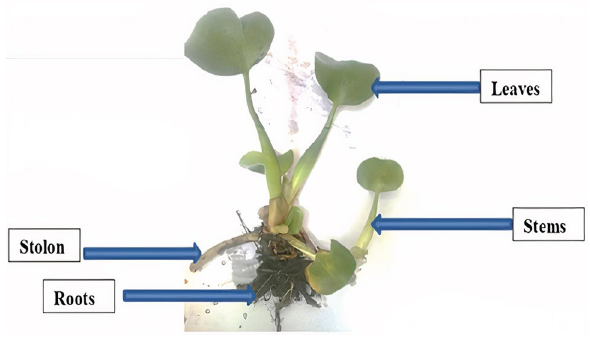
Fig. 4 Eichhornia crassipes (Mart.) Solms ( Source : the